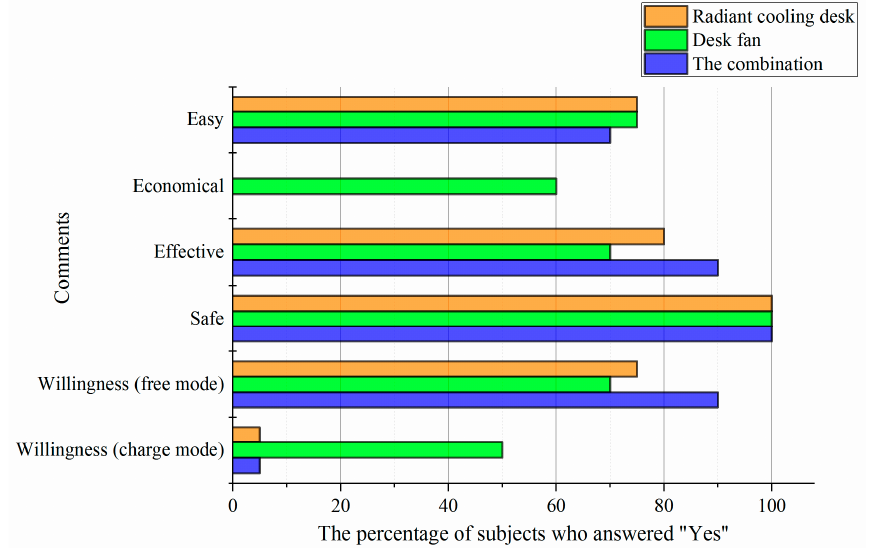
Figure 11. Percentages of participants who gave positive comments on personal cooling systems.